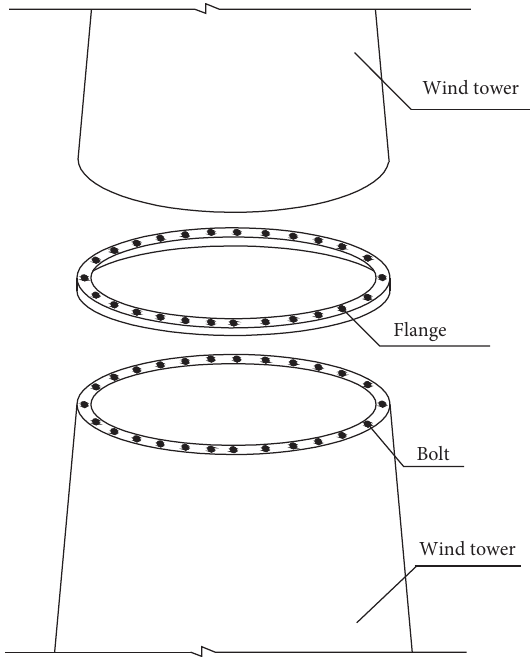
Figure 2: Flange connection of wind